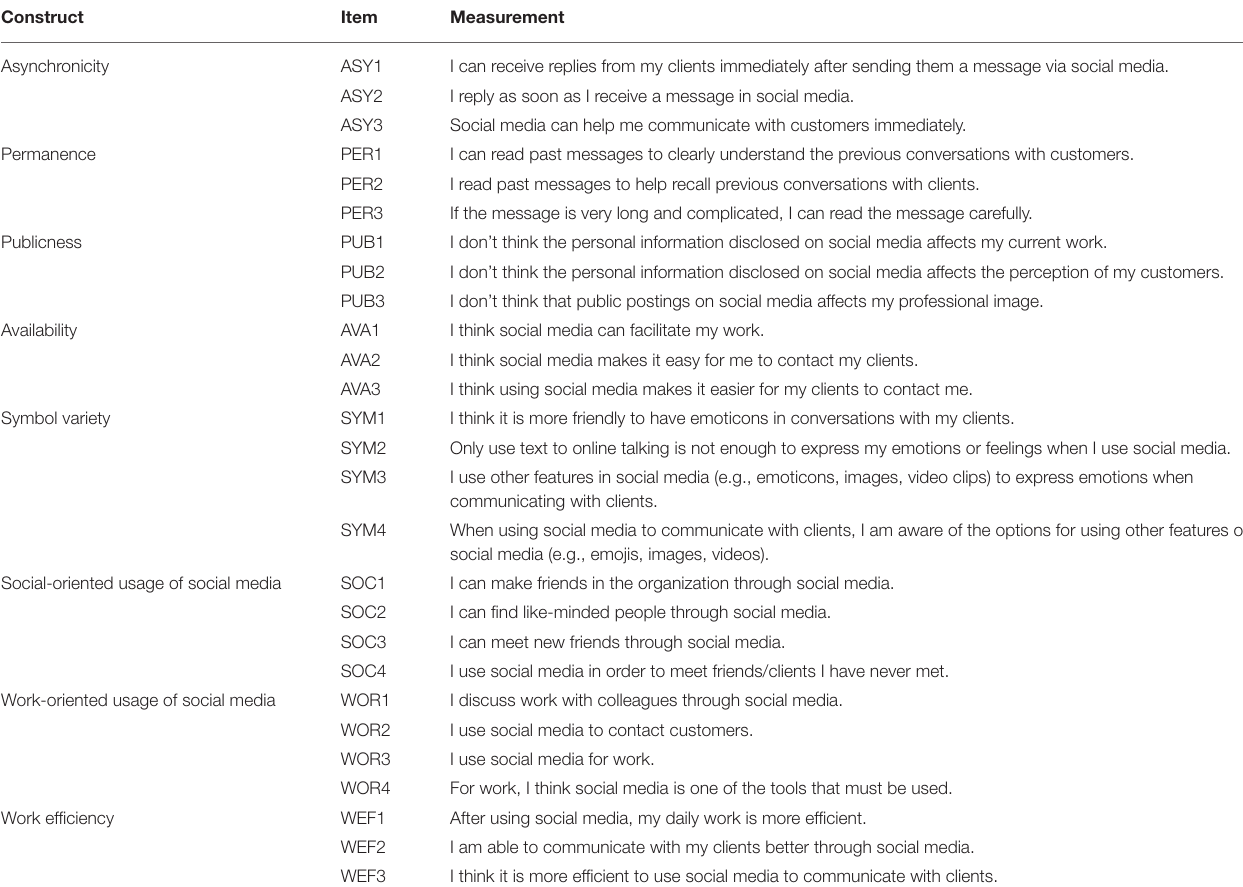
TABLE A1 | Measurement